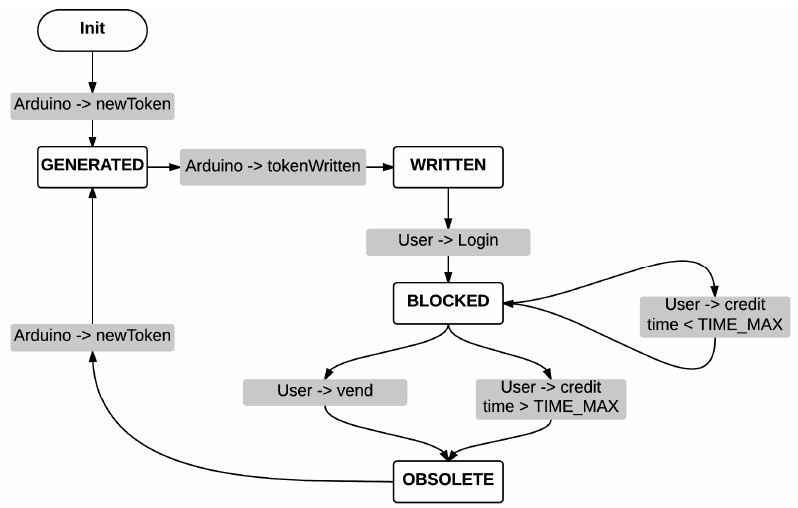
Figure 3. Token life cycle.